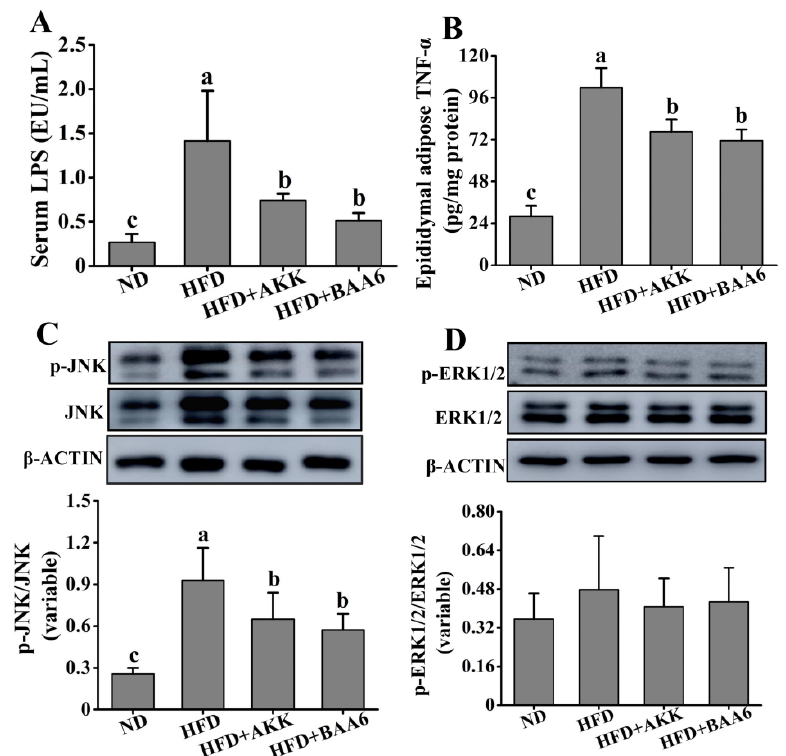
Figure 4. E ff ects of oral administration of BAA6 or AKK on inflammation in HFD-fed mice. ( A ) The level of serum lipopolysaccharides (LPS). ( B ) Tumor necrosis factor α (TNF- α ) concentration in epididymal adipose tissues. Protein expression levels of ( C ) phosphorylated c-Jun N-terminal kinase ( p -JNK) / JNK and ( D ) phosphorylated extracellular signal-regulated kinase 1 / 2 ( p -ERK1 / 2) / ERK1 / 2 in epididymal fat tissues following daily treatment with 10 9 CFU / kg BAA6 or AKK. Values are expressed as means ± SD ( n = 6). Bars with di ff erent lowercase letters denote significant di ff erences among groups ( p < 0.05). 2.5. BAA6 Increased Endothelial Nitric Oxide Synthase (eNOS) Expression and Mitochondrial Biogenesis